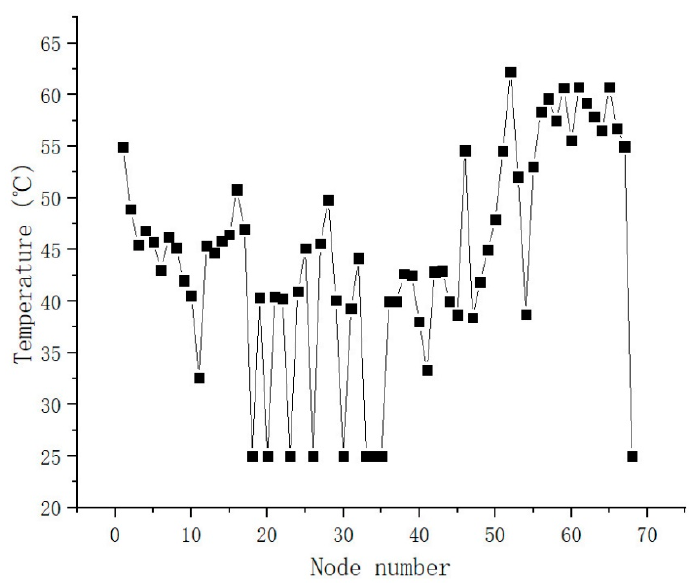
Figure 8. The TFD of the planetary automobile drive axle ( p = 22 kW).